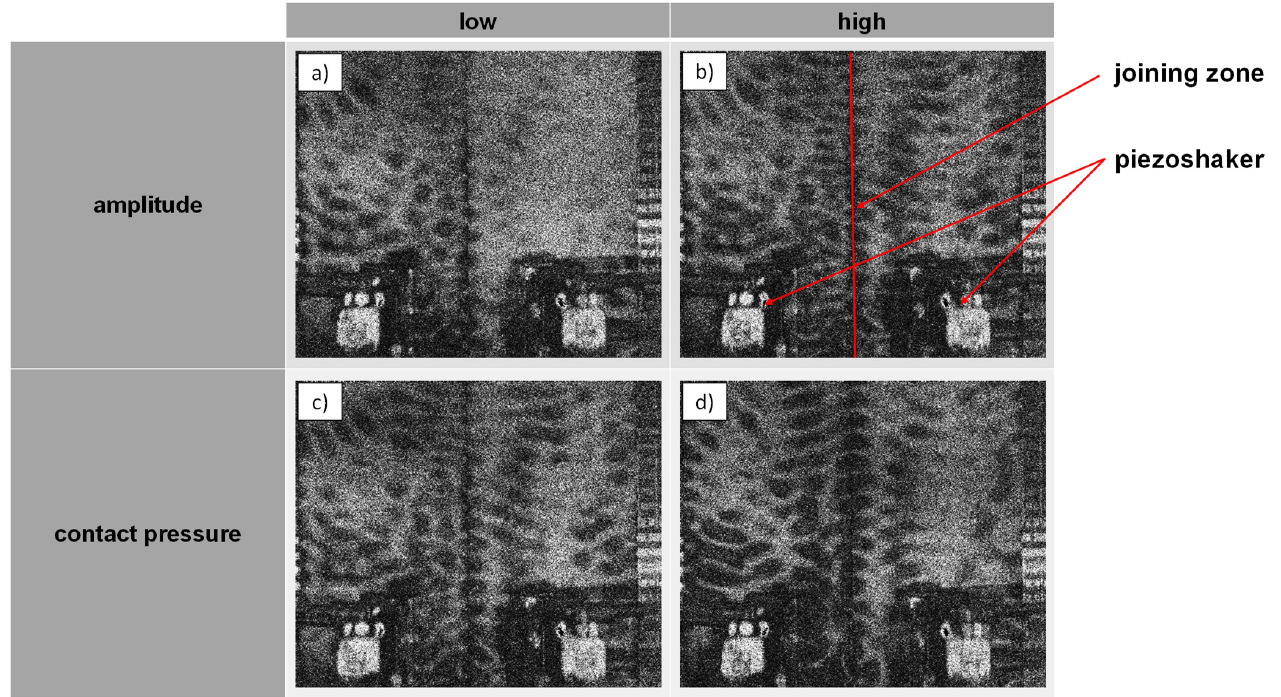
Figure 4. Shearography measurement to investigate the influence of excitation amplitude ( a , b ) and contact pressure ( c , d ) on the soundwave coupling.